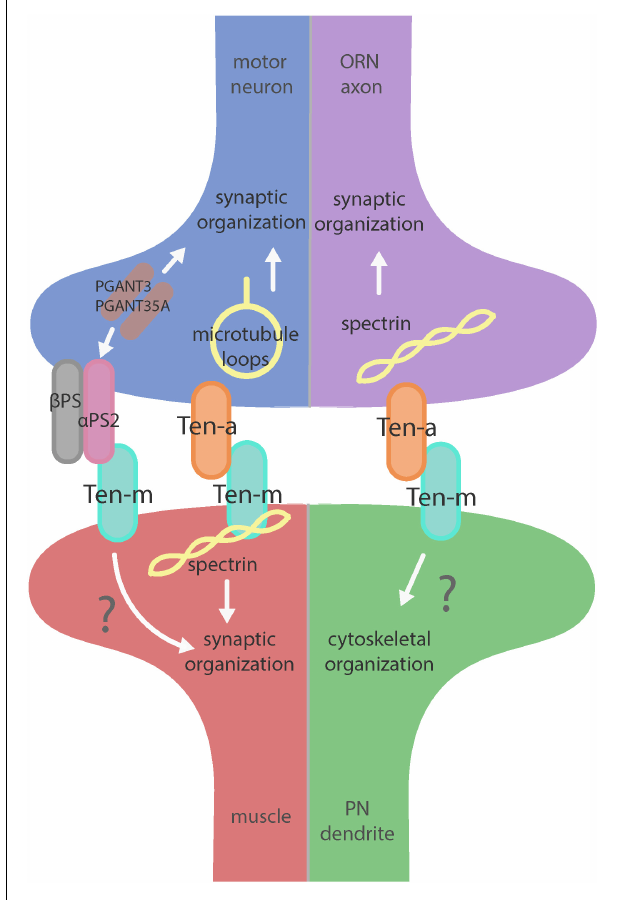
FIGURE 2 | Teneurin-mediated synaptic organization in the CNS and PNS. Teneurins are involved in synaptogenesis in the PNS (left) and CNS (right). Both systems utilize transsynaptic heterophilic Teneurin interaction to instruct synaptic organization. At the NMJ, presynaptic Ten-a is involved in the formation of stable microtubule loops, promoting synaptic organization. Ten-m in the muscle interacts directly with spectrin, as well as potentially with α PS2 to mediate synaptic organization. In the CNS, however, presynaptic Ten-a functions with spectrin to promote synaptic organization. The role of postsynaptic Ten-m is unknown but may regulate downstream cytoskeletal components.